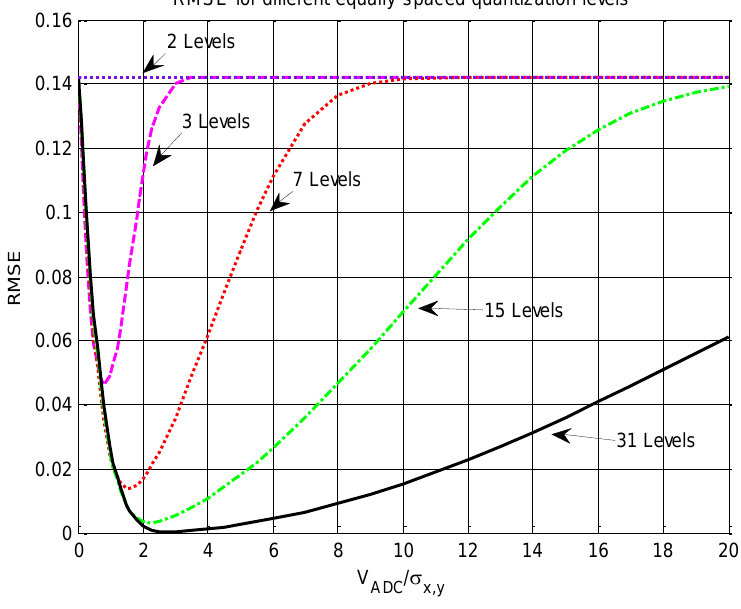
Figure 3. Root mean square error and ADC span window relationship for different equally spaced quantification